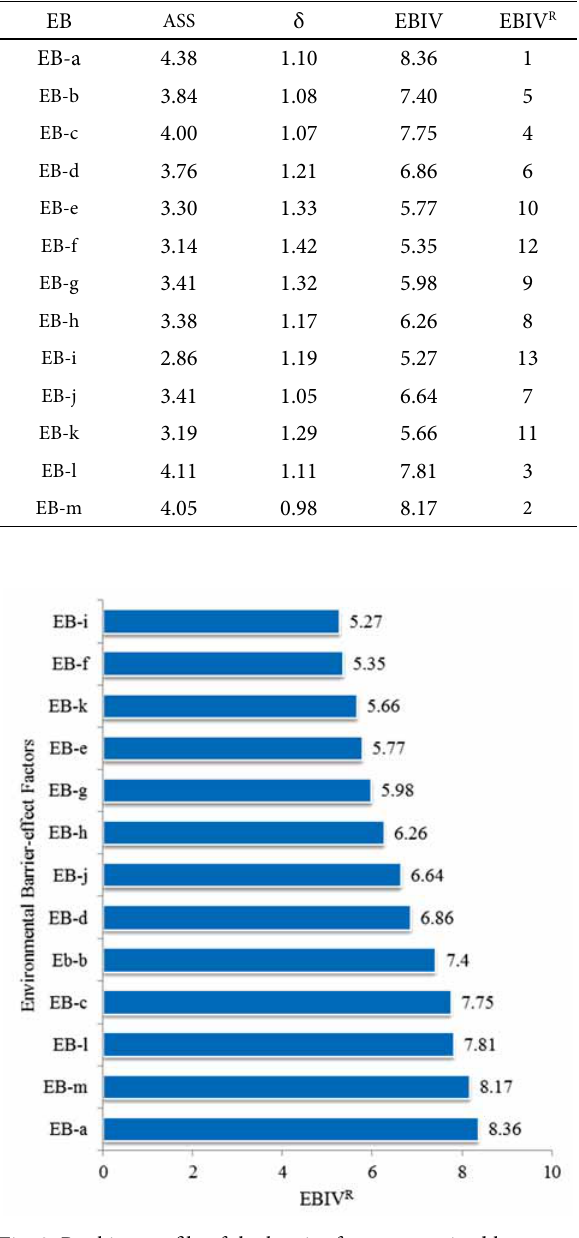
Fig. 2. Ranking profile of the barrier factors perceived by Nigerian construction